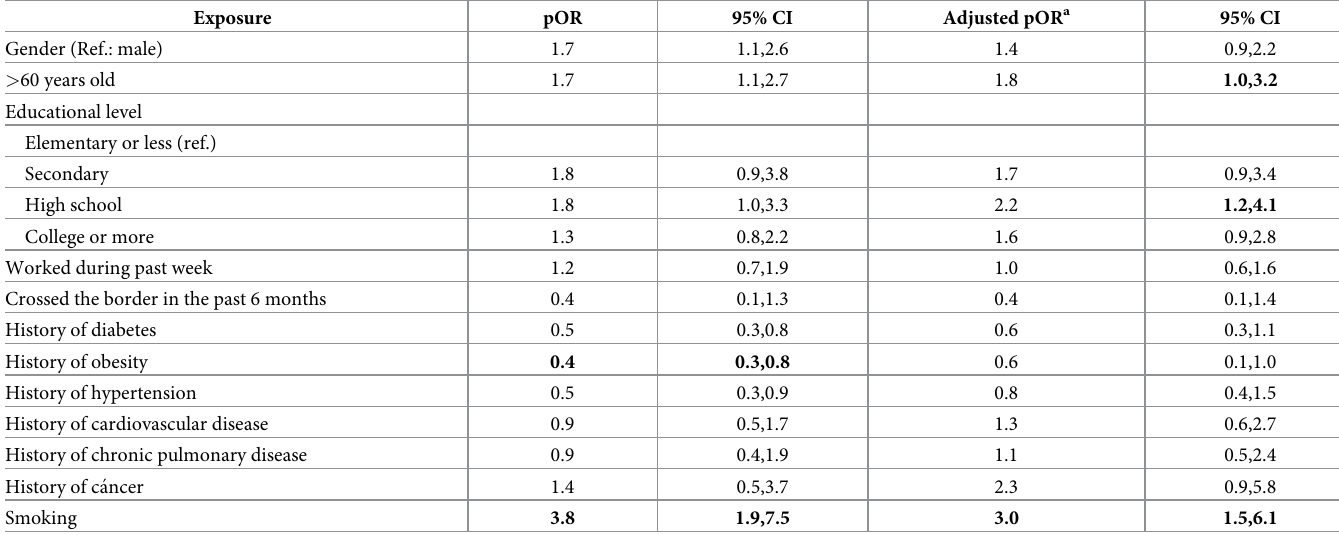
Table 5. Association between COVID-19 (IgG positivity) and